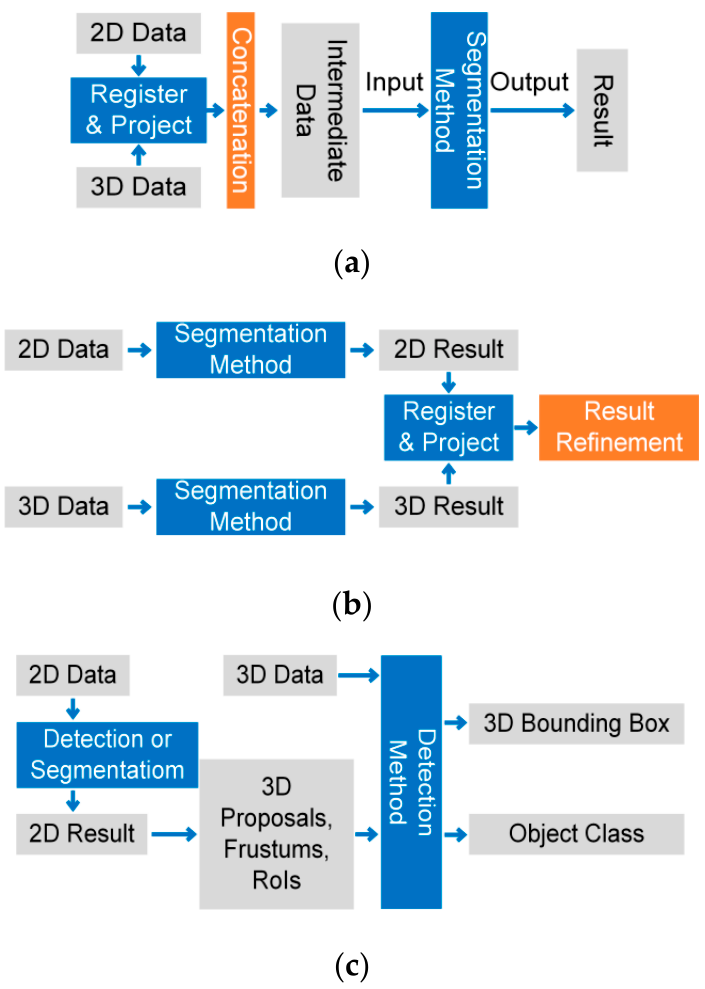
Figure 10. The general structure of non-feature-based fusion strategy. ( a ) Data-based fusion strategy; ( b ) result-based fusion strategy; ( c ) data–result-based fusion strategy.